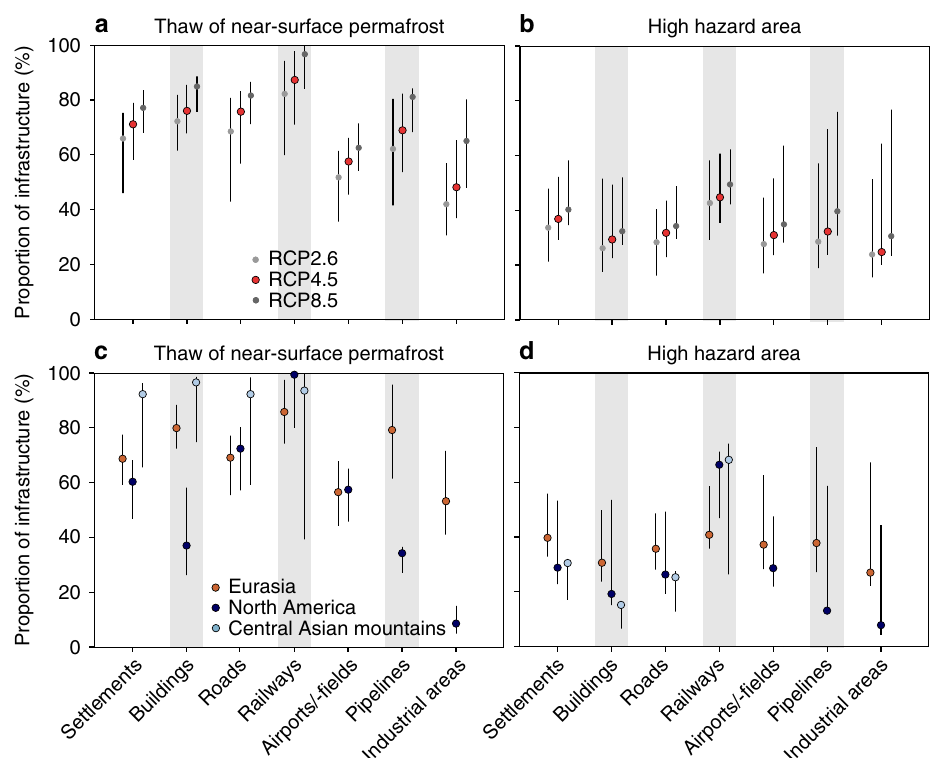
Fig. 2 Central results of the infrastructure hazard computations. Proportion of all residential, transportation, and industrial infrastructure in areas of near- surface permafrost thaw ( a ) and high hazard ( b ) in the pan-Arctic permafrost area based on different Representative Concentration Pathway (RCP) scenarios by the middle of the century (2041 – 2060). The comparable results of RCP4.5 for geographical sub-regions (Eurasia, North America and central Asian mountains) are presented in ( c ) and ( d ) (also 2041 – 2060; percentages for airports/- fi eld, pipelines and industrial areas are not shown for central Asian mountains owing to too few observations). The numerical results are presented in Supplementary Table 3. The uncertainty ranges (bars) were based on the uncertainty in the mean annual ground temperature ( a – d ) and active layer thickness predictions ( b and d